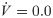
Performance of the motif 1 zero-order controller with internally generated compensatory flux (Fig 17; Eqs 50–54).Phase 1: constant volume V and constant k3. Initial volume, concentrations, and rate constants: V0 = 25.0, V˙=0.0, A0 = 0.0, E0 = 0.0, M0 = 4 × 104, N0 = 1 × 105, P0 = 0.0, k2 = 1.0, k3 = 2.0, k3˙=0.0, k4 = 20.0, k5 = 1 × 10−6, k6 = 10.0, k7 = 1 × 10−6, k8 = 1 × 10−6. The controller moves A to its set-point at Asettheor=(k4/k6)=2.0 (Eq 55). Phase 2: rate constants remain the same as in phase 1, but V increases linearly with V˙=2.0, while k3 remains constant at k3 = 2.0. The controller is able to keep A at Asettheor=(k4/k6)=2.0 in agreement with Eq 55. Phase 3: V continues to increase with the same speed while k3 now linearly increases with k3˙=1.0. As indicated by Eq 55
Ass leads to a constant offset below Asettheor.